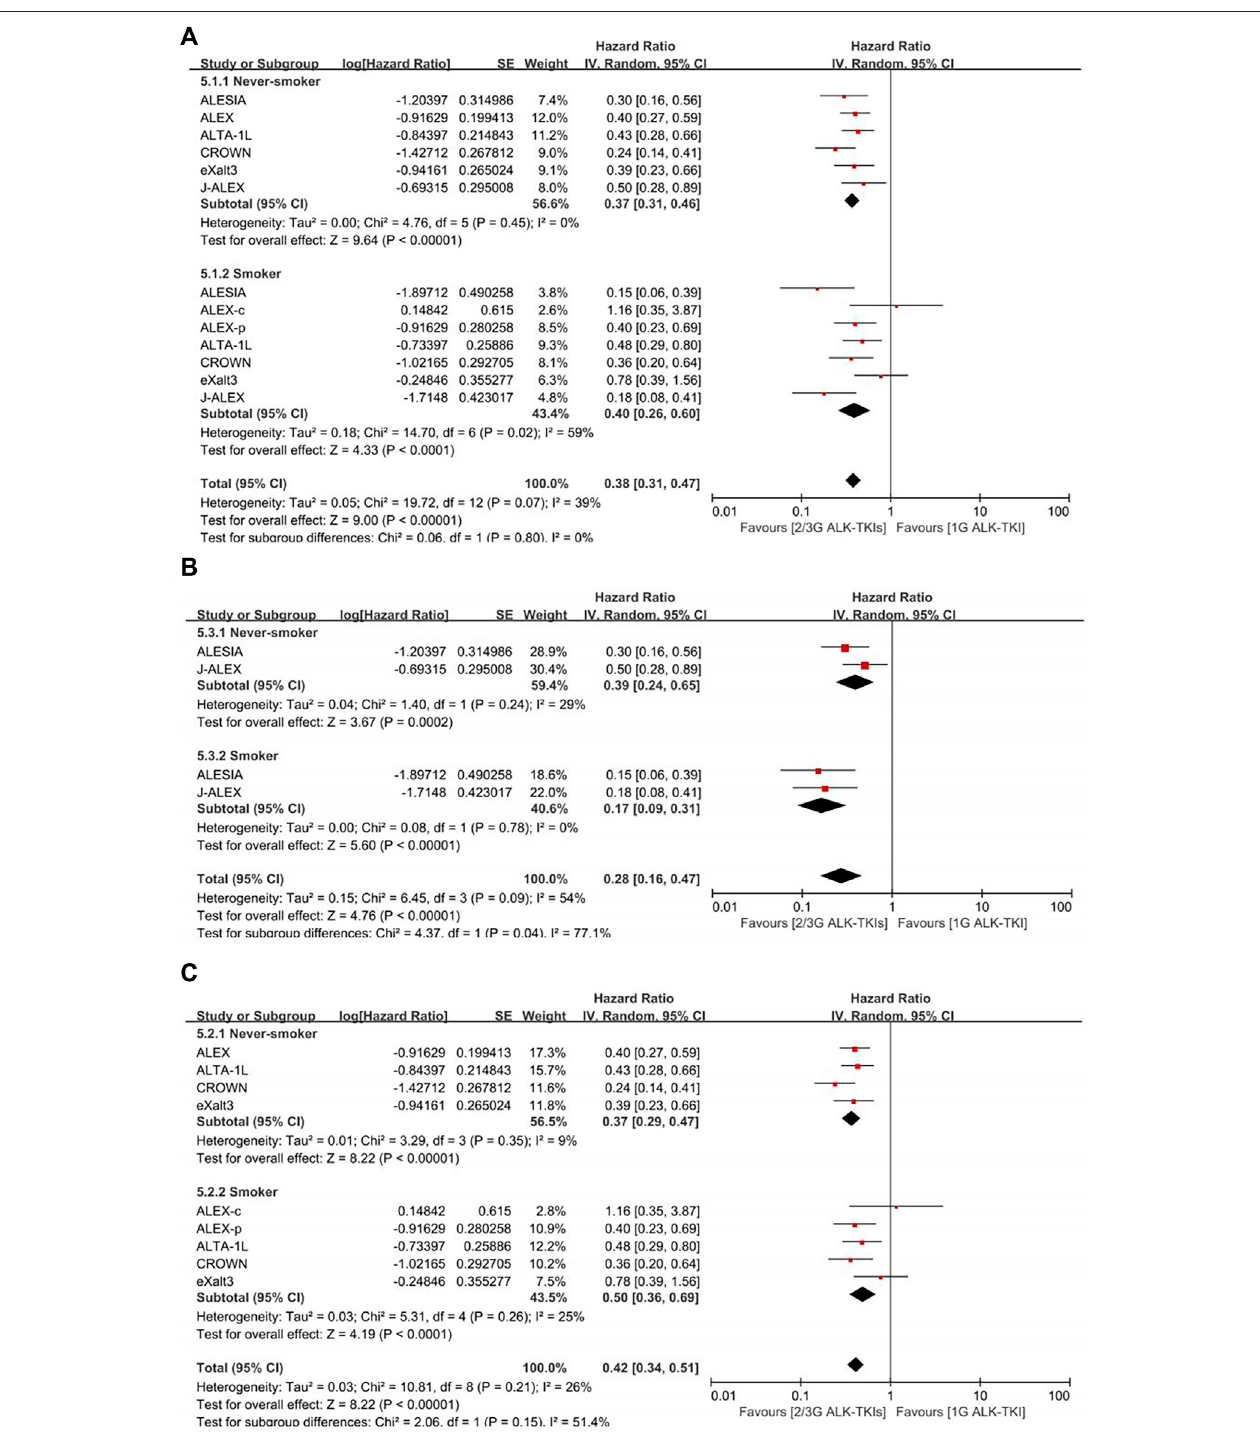
FIGURE 3 | Comparison between smoking status subgroups in crizotinib-controlled studies. (A) Initial analysis. (B) Asian-only subgroup analysis. (C) Multiracial subgroup analysis. ALEX-c, current smoker subgroup of ALEX; ALEX-p, previous smoker subgroup of ALEX; 2/3G ALK-TKIs, both second- and third-generation anaplastic lymphoma kinase tyrosine kinase inhibitors; 1G ALK-TKI, fi rst-generation anaplastic lymphoma kinase tyrosine kinase inhibitor.